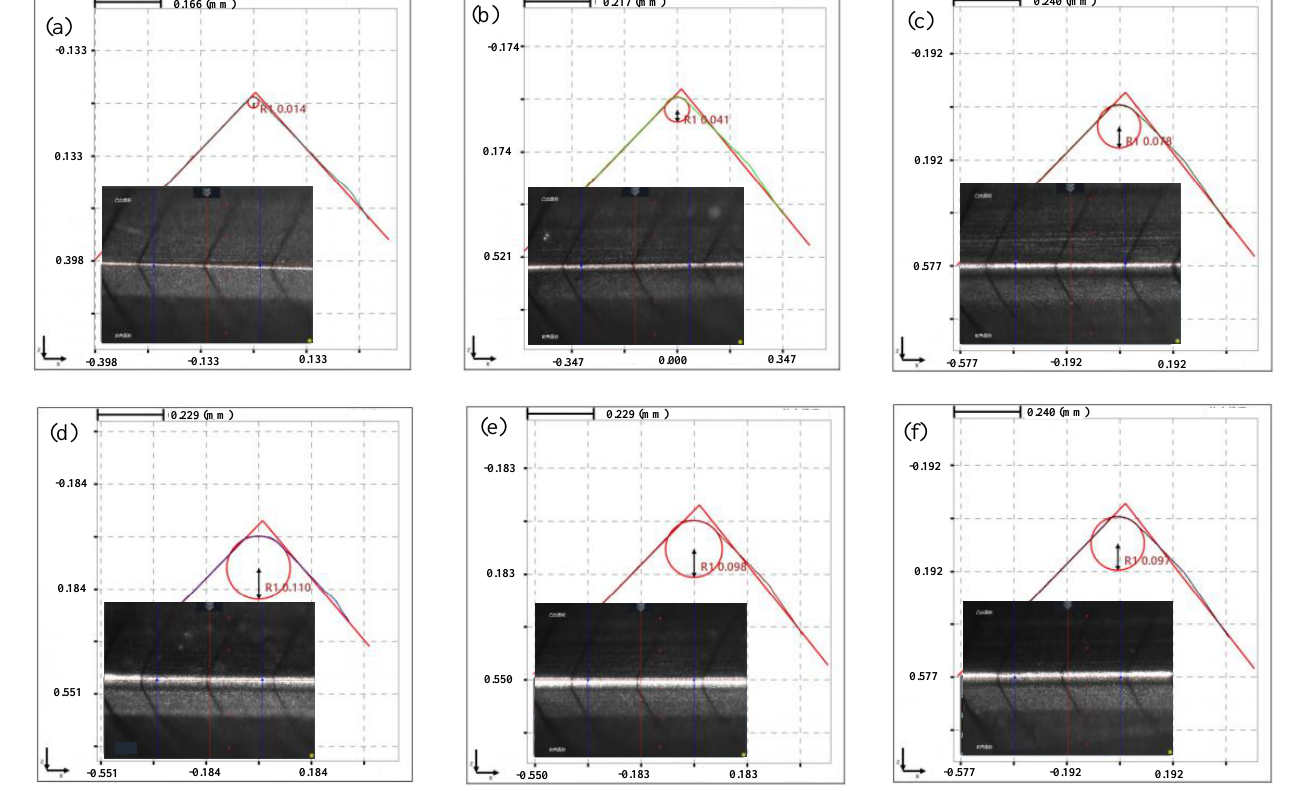
Figure 16. Edge shape diagram under different polishing velocity: ( a ) before preparation ( b ) v = 50